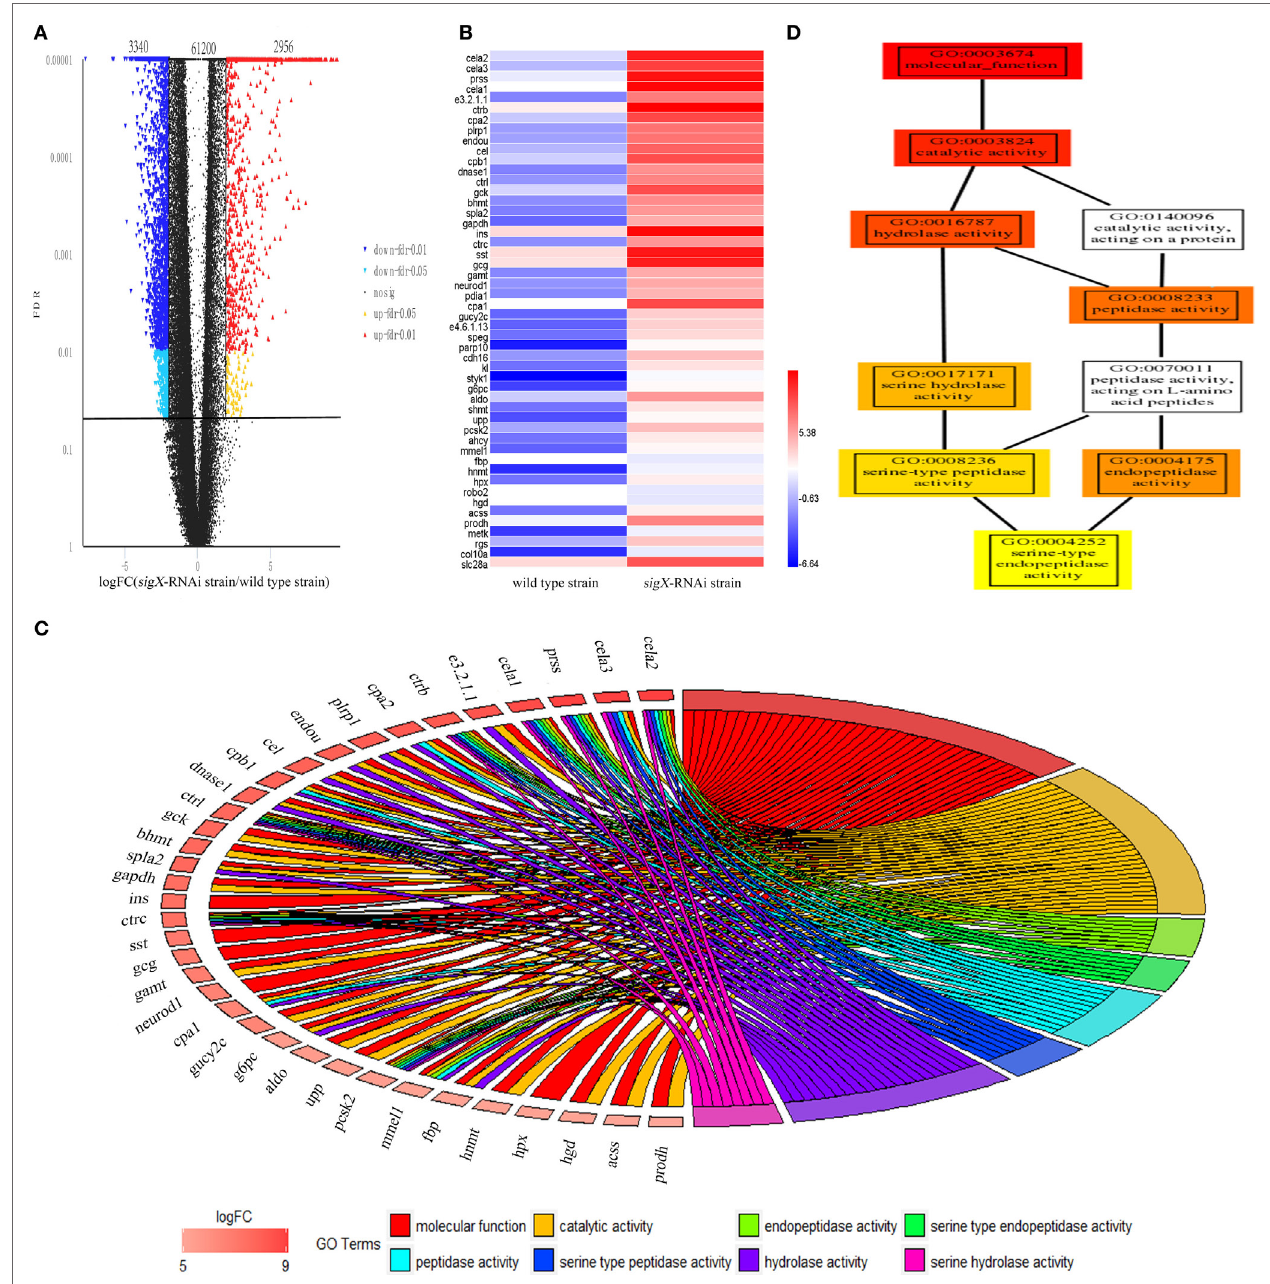
FigUre 3 | Differentially expressed genes (DEGs) of Epinephelus pinephelus infected by Pseudomonas plecoglossicida and gene ontology (GO) analysis. (a) Volcano plot of all genes, X -axis represent the fold change values of samples infected by sigX -RNAi strain/samples infected by wild-type strain, Y -axis represent statistical test value [false discovery rate (FDR)], the higher represent the more significant differences. Each dot represents a particular gene: the red dots indicate significantly up-regulated genes; the blue dots represent significant down-regulated genes; and the black dots represent non-significant differences genes. (B) Heat map of the top 50 up-regulated genes (adjusted FDR < 0.05; ǀ log2FC ǀ ≥ 1; 3 biological replicates) between wild-type strain and sigX -RNAi strain infections. Values represent log2 folds. Colors based on log-transformed transcripts FPKM mean values. Blue and red indicate decreased and increased expression, respectively. (c) Chordal graph of top 50 DEGs to GO terms. (D) GO-directed acyclic graph chart of 8 GO terms which belongs to molecular function. Each node at the right half of the circle represents one of the 8 GO term, each node at the left half of the circle represents a gene. The degree of colors represents the enrichment significance levels according to P -value. The redder the color of the gene, the greater the up-regulation of the expression.